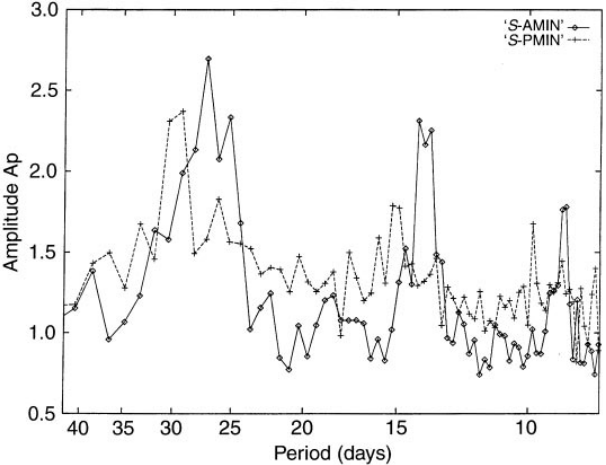
Fig. 4. Average spectral amplitude of Ap for years before sunspot minimum with a 27-day period of the IMF sector structure, S-AMIN, and of years after sunspot minimum with 28–28.5-day recurrence period of the IMF sector structure, S-PMIN. The spectral Ap amplitudes a n are smoothed with a n (cid:136) 0 : 25 a (cid:19) (cid:135) are the original Fourier amplitudes. Notice the log-scale of the abszissa in the period range